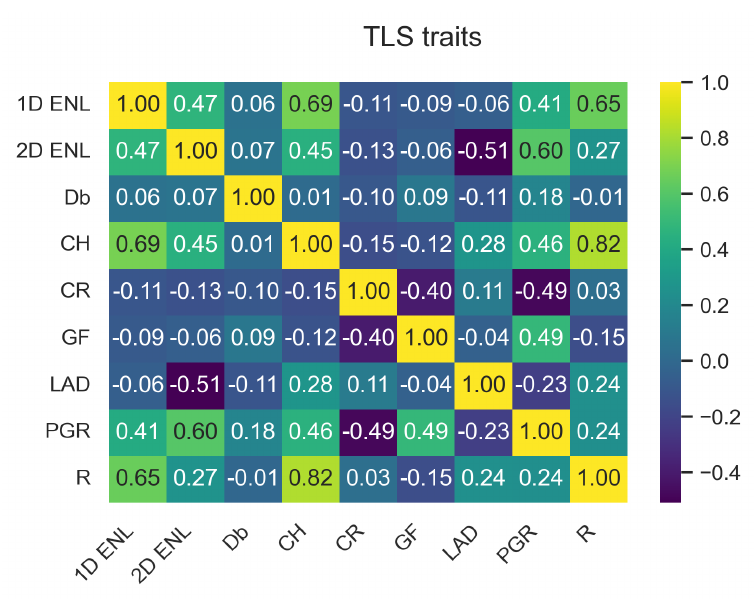
Figure A22. ULS correlation matrix at 1m Grid Size.